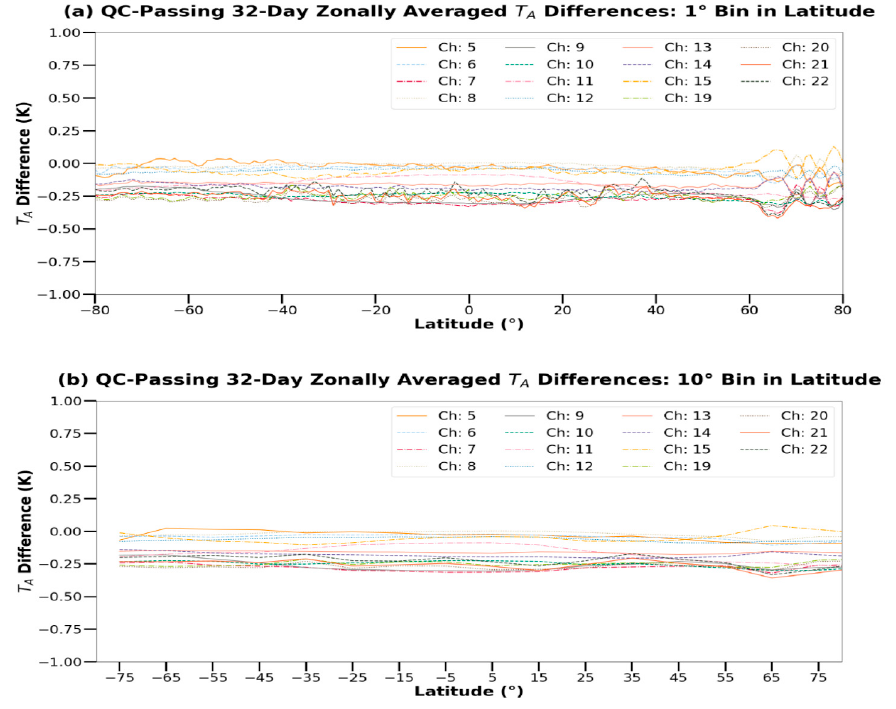
Figure 9. Zonal means of ∆ O N 20 − SNPP (𝑖, 𝑗) at 15 channels for SNPP and NOAA-20 ATMS TDR QC32 D , Point data after the QC scheme is applied, where the 15 channels correspond to the channels of 22 ATMS channels by removing 1 to 4 and 16 to 18. In the figure, the data are in the descending node covering the period from 1 November 2020, to 2 December 2020; the zonal bins are calculated per 1 ° and 10 ° of running bin, respectively, where the center frequency within the 10 ° bin is used as the index of latitude per bin. ( a ) Zonal mean per 1 ° of latitude bin. ( b ) Zonal mean per 10 ° of latitude bin.